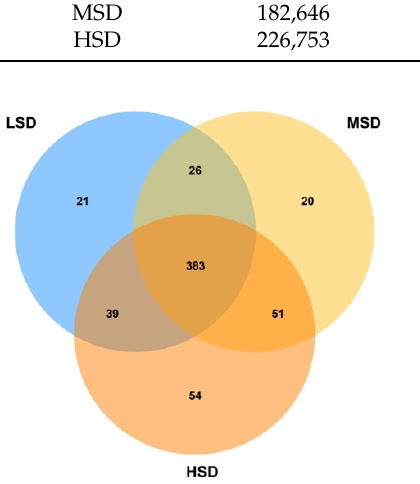
Figure 2. The intestinal contents of Kunming mice with different feeding densities were analyzed by 16S rRNA. Venn of bacterial communities (based on OTUs) in the sediment of treatments with different stocking densities in different density